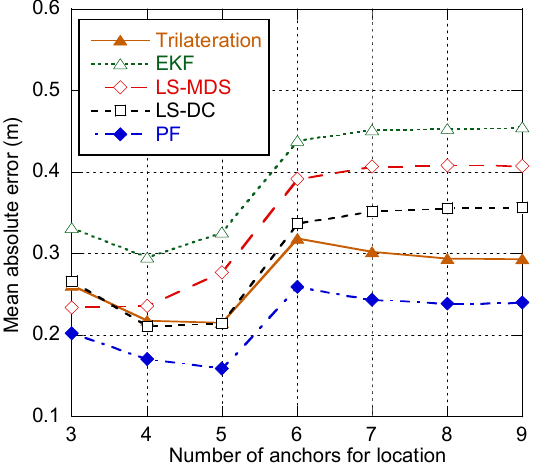
Figure 14. Positioning error for the target-centered architecture (MRq SRp DA).